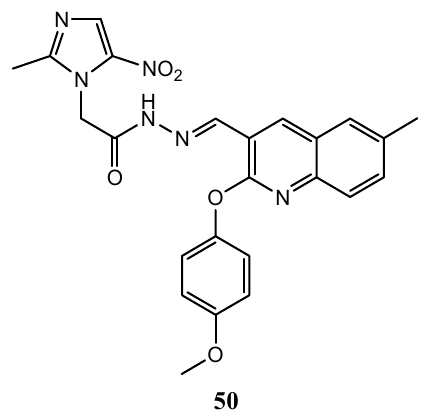
Figure 24. Schiff’s base quinoline derivative as EGFR tyrosine kinase inhibitor [122].